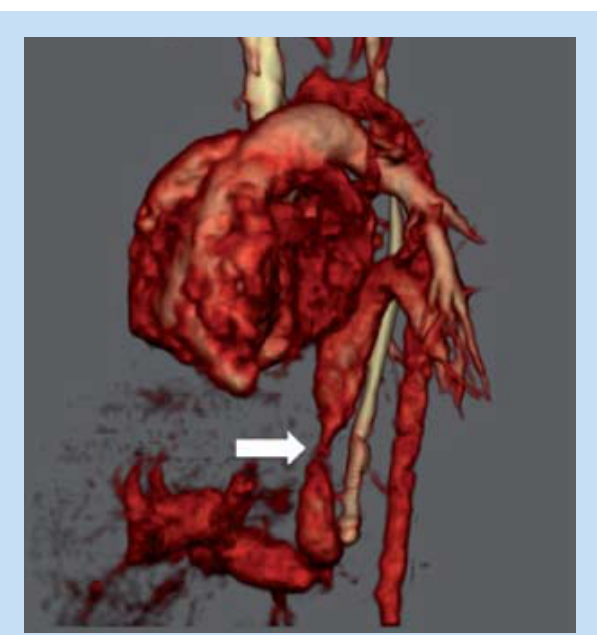
Fig. 2c. Volume-rendered image of the CT angiogram showing the narrowing of the common venous channel (arrow) at the oesophageal